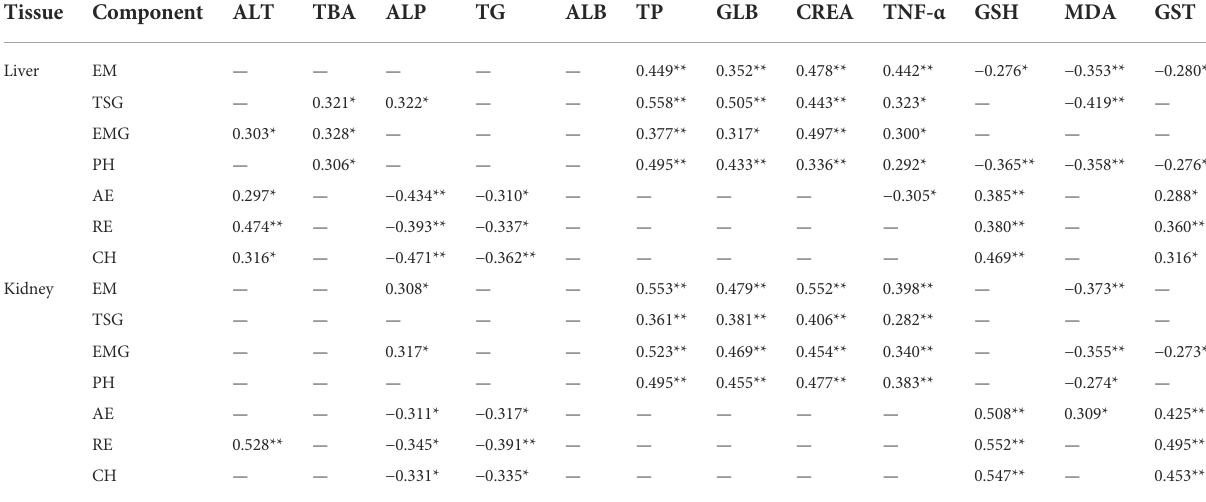
TABLE 5 Pearson correlation coef fi cients between hepatic and renal exposure and biochemical index in this PM hepatotoxicity study ( n = 6). Tissue Component Liver